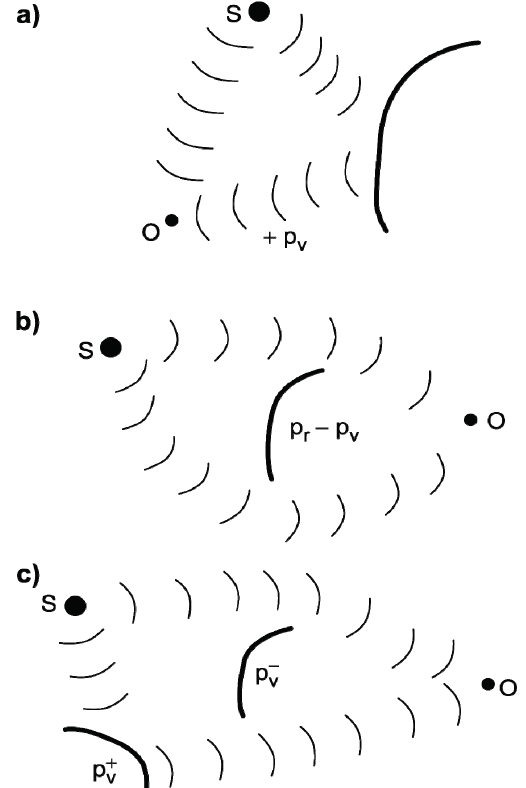
Figure 4. Acoustic installation effects: reflection and shielding. The acoustic